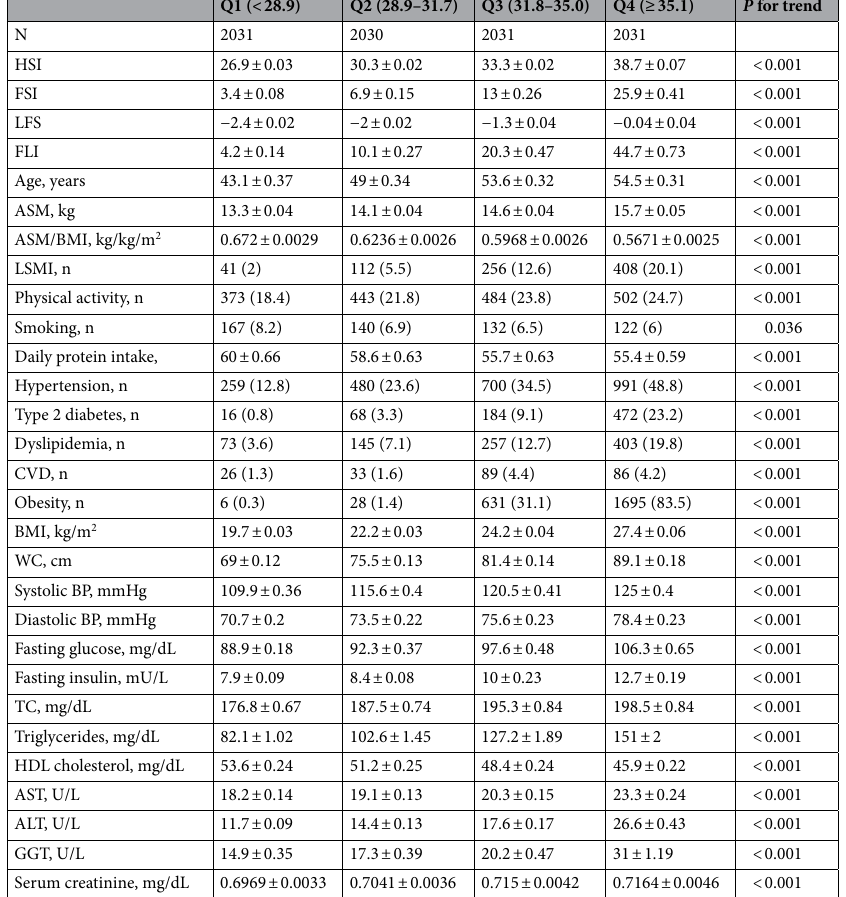
Table 4. General characteristics of Korean women based on quartile of HSI level. HSI hepatic steatosis index, FSI Framingham steatosis index, LFS NAFLD liver fat score, FLI fatty liver index, ASM